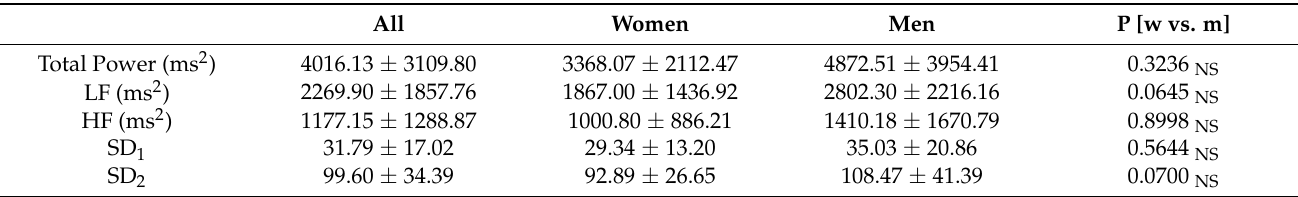
Table 5. Analysis of heart rate variability—HRV in the frequency domain.